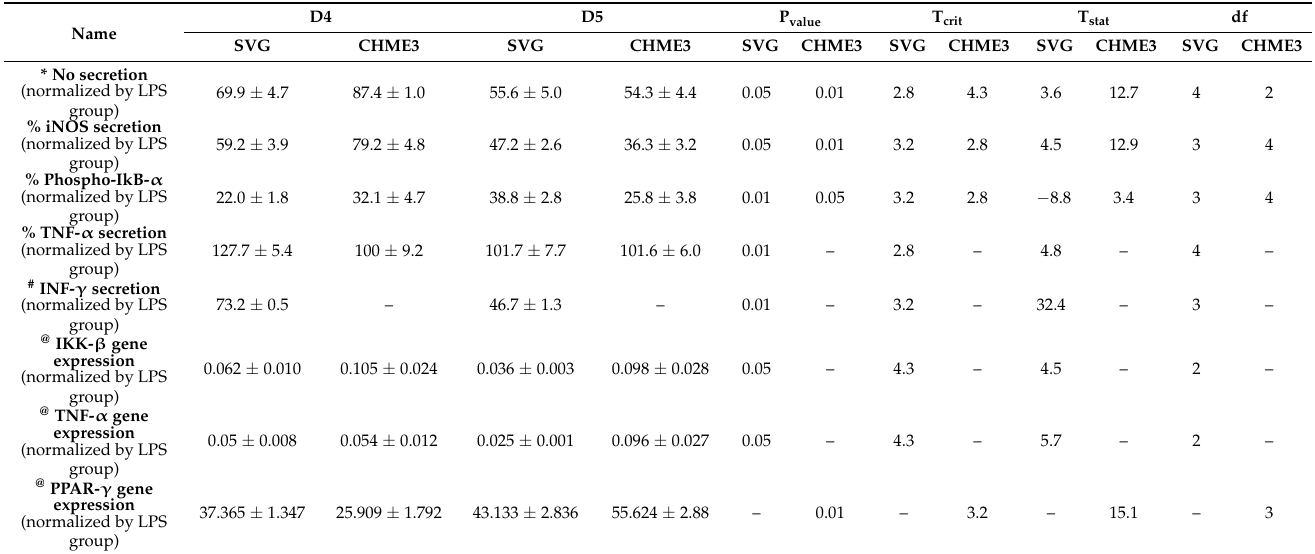
Table 3. Efficacy comparison between methylenedioxy (D5) and hydroxymethyl (D4) piperamides on the neuroinflammatory cytokine protein and